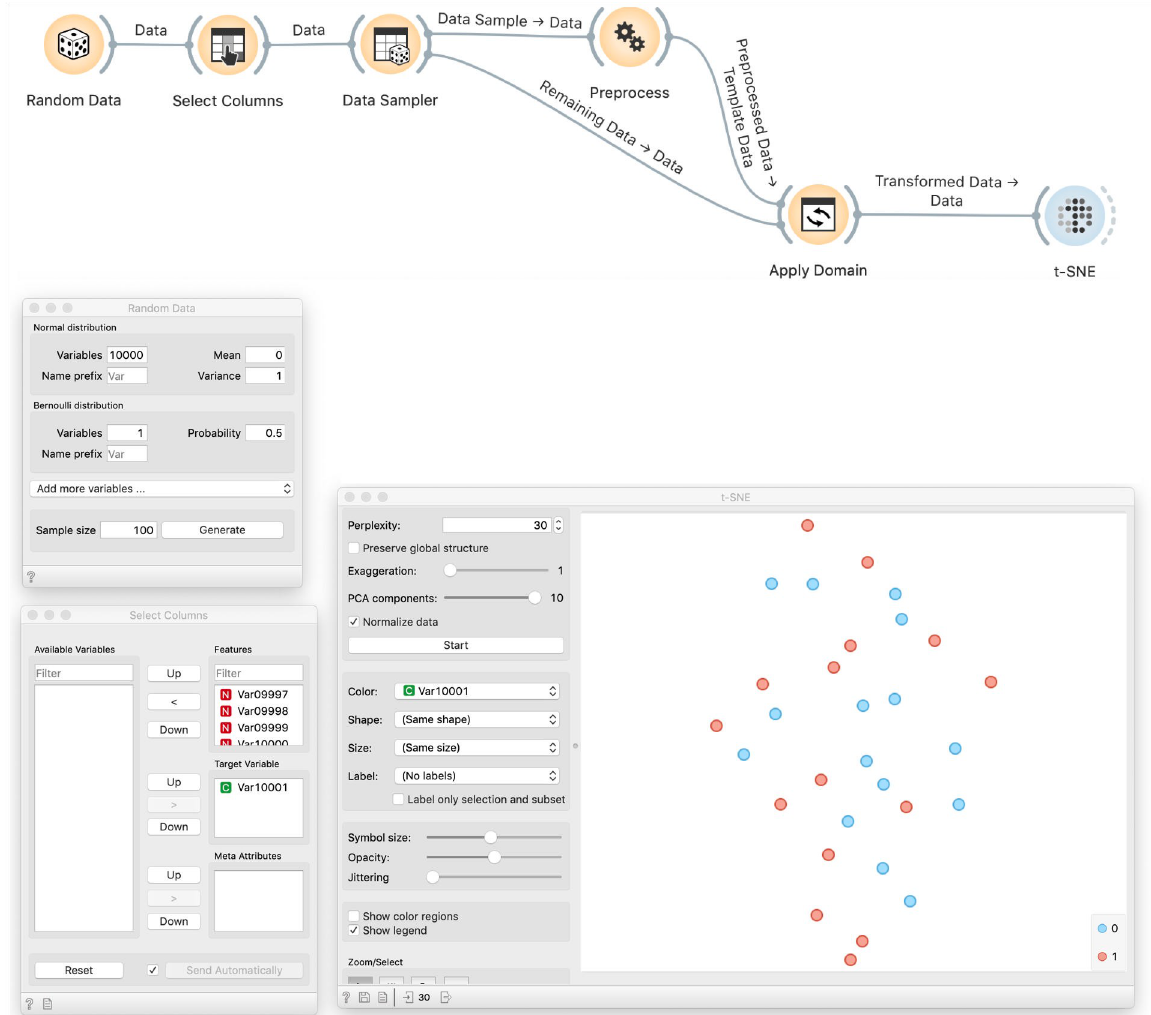
Fig 13. t-SNE visualization of a separate test data. This workflow uses a random sample to discover the most informative variables, that is, variables that are most correlated with the class variable. The Apply Domain then takes the out-of-sample data and applies the transformation from the Preprocess widget, and in this case, removes all except the ten variables chosen from the sample data. In this way, the procedure that selects the variables is not informed by the data that is shown in the visualization. This time, the data plot does not expose any class structure; red and blue data points are intermixed. Compare this outcome to the overfitted visualization from Fig